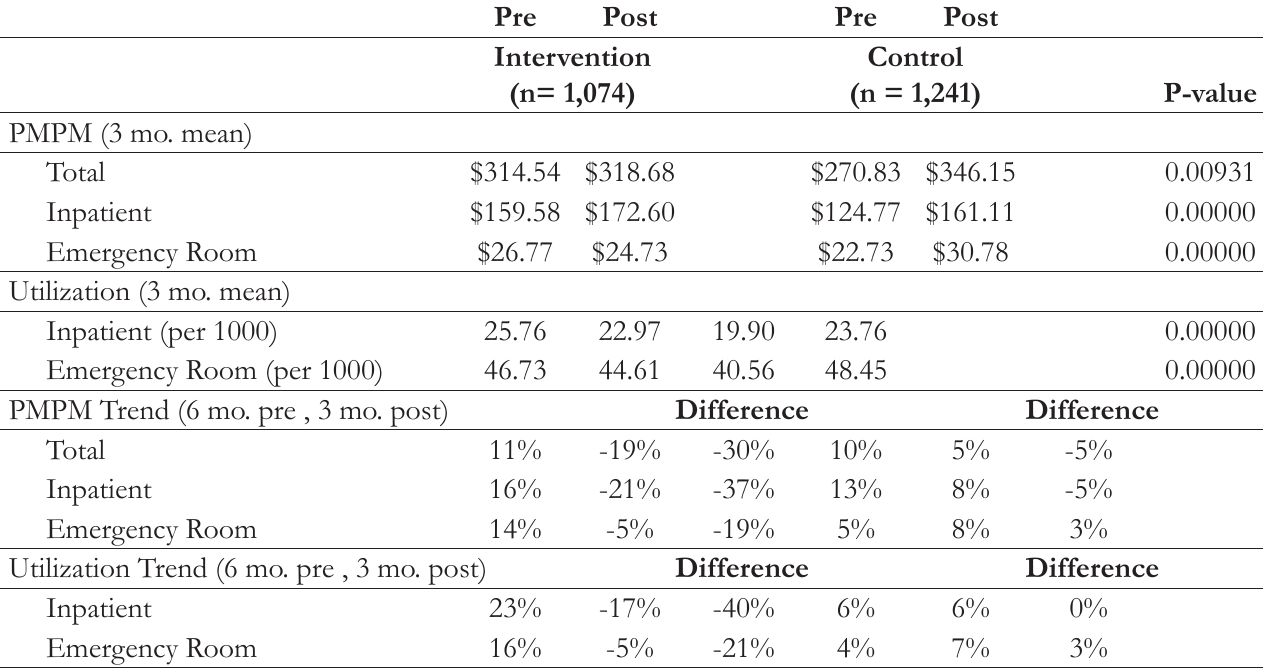
Table 2b. Risk-adjusted PMPM Costs, Utilization and